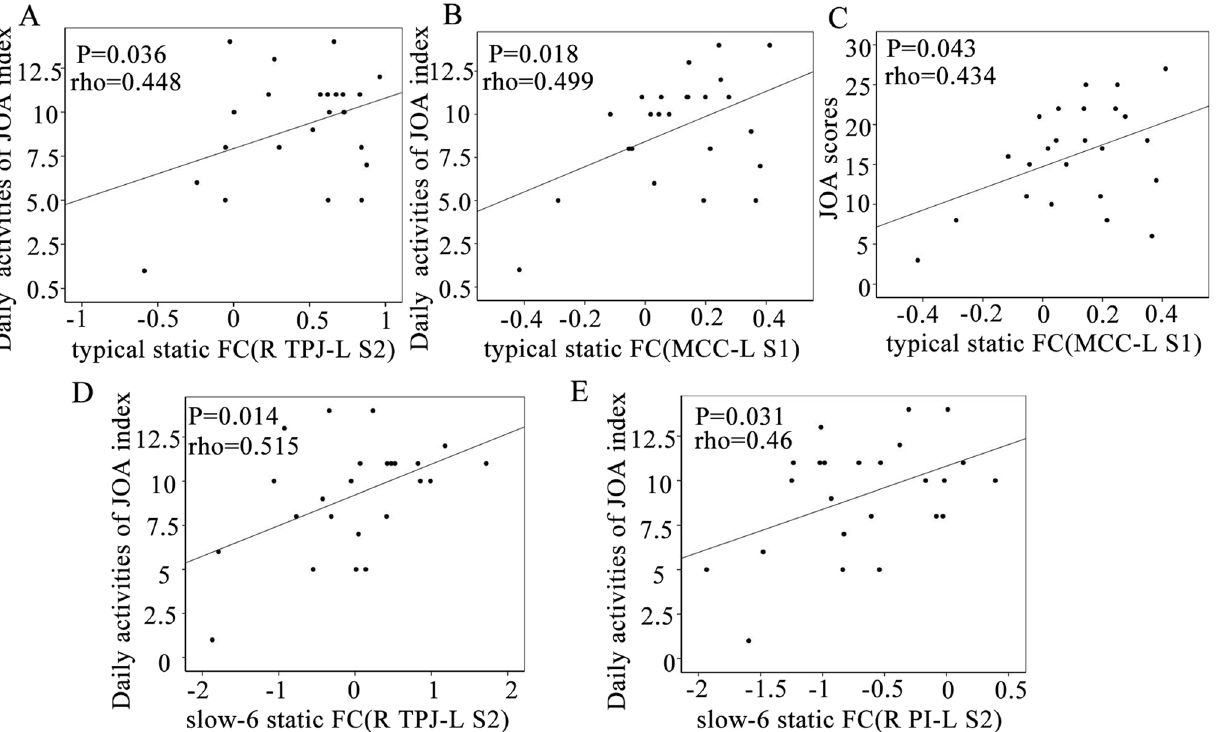
Figure 6. Partial correlational analysis between abnormal static FC and clinical assessment scores in LBLP patients. JOA Japanese orthopaedic